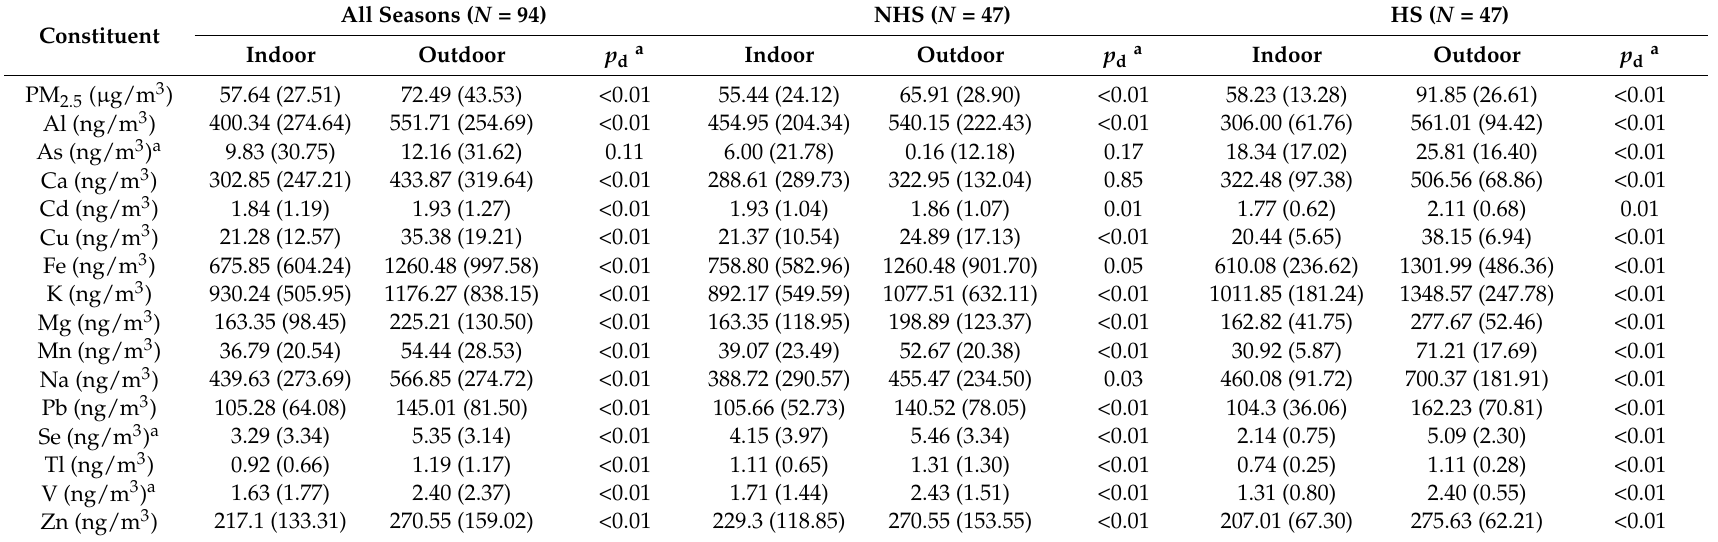
Table 2. Distribution of residential indoor and outdoor concentration of PM 2.5 and elements (median (IQR: Interquartile